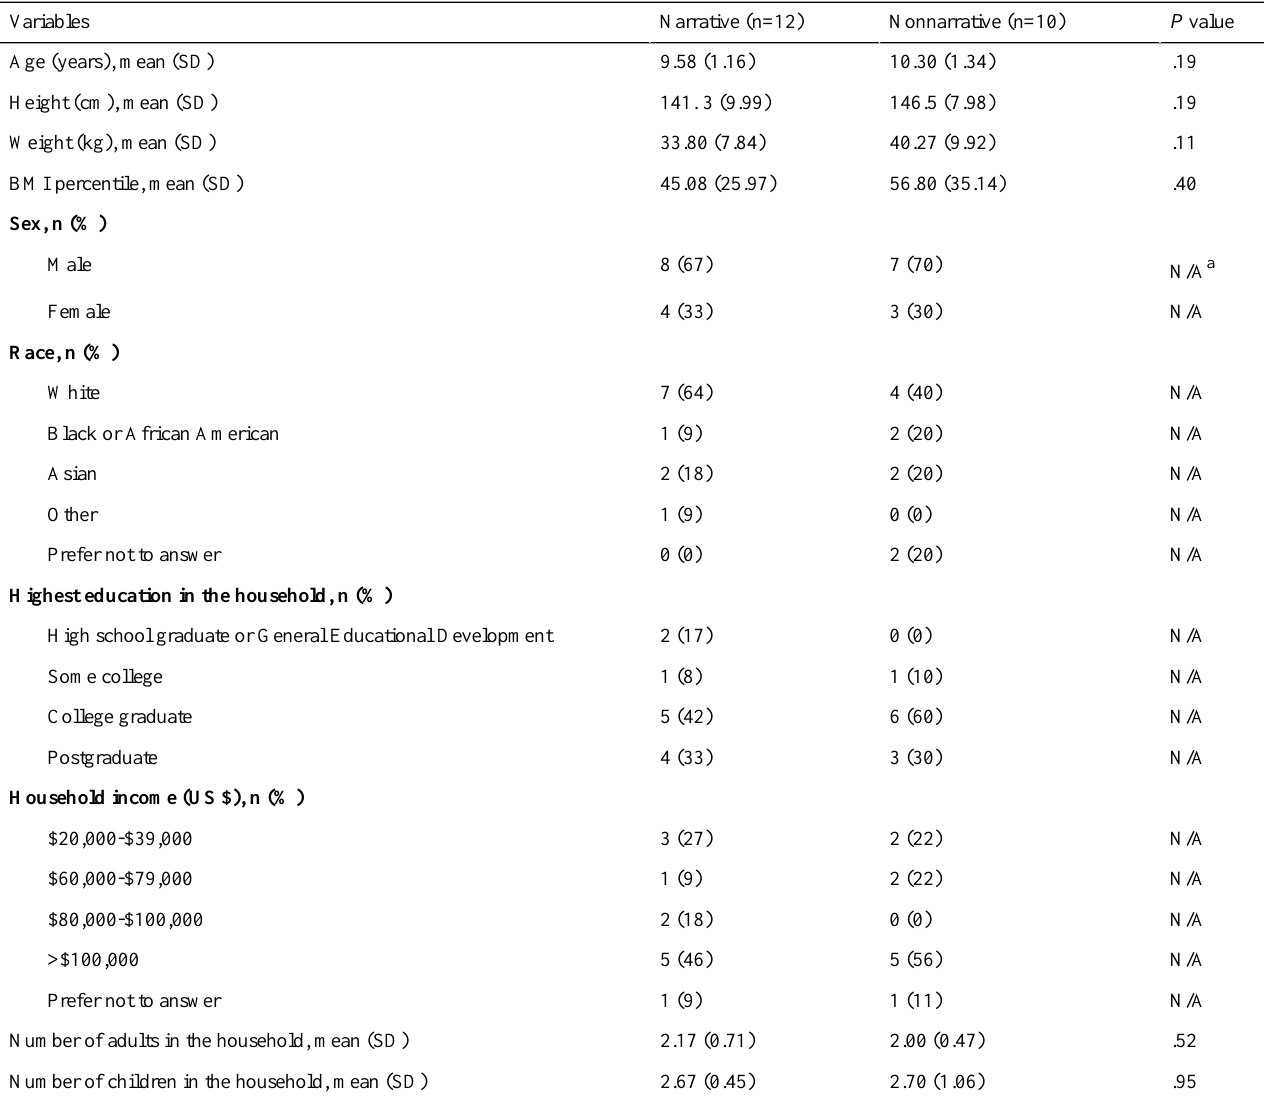
Table 1. Age, anthropometrics, and demographic characteristics of the